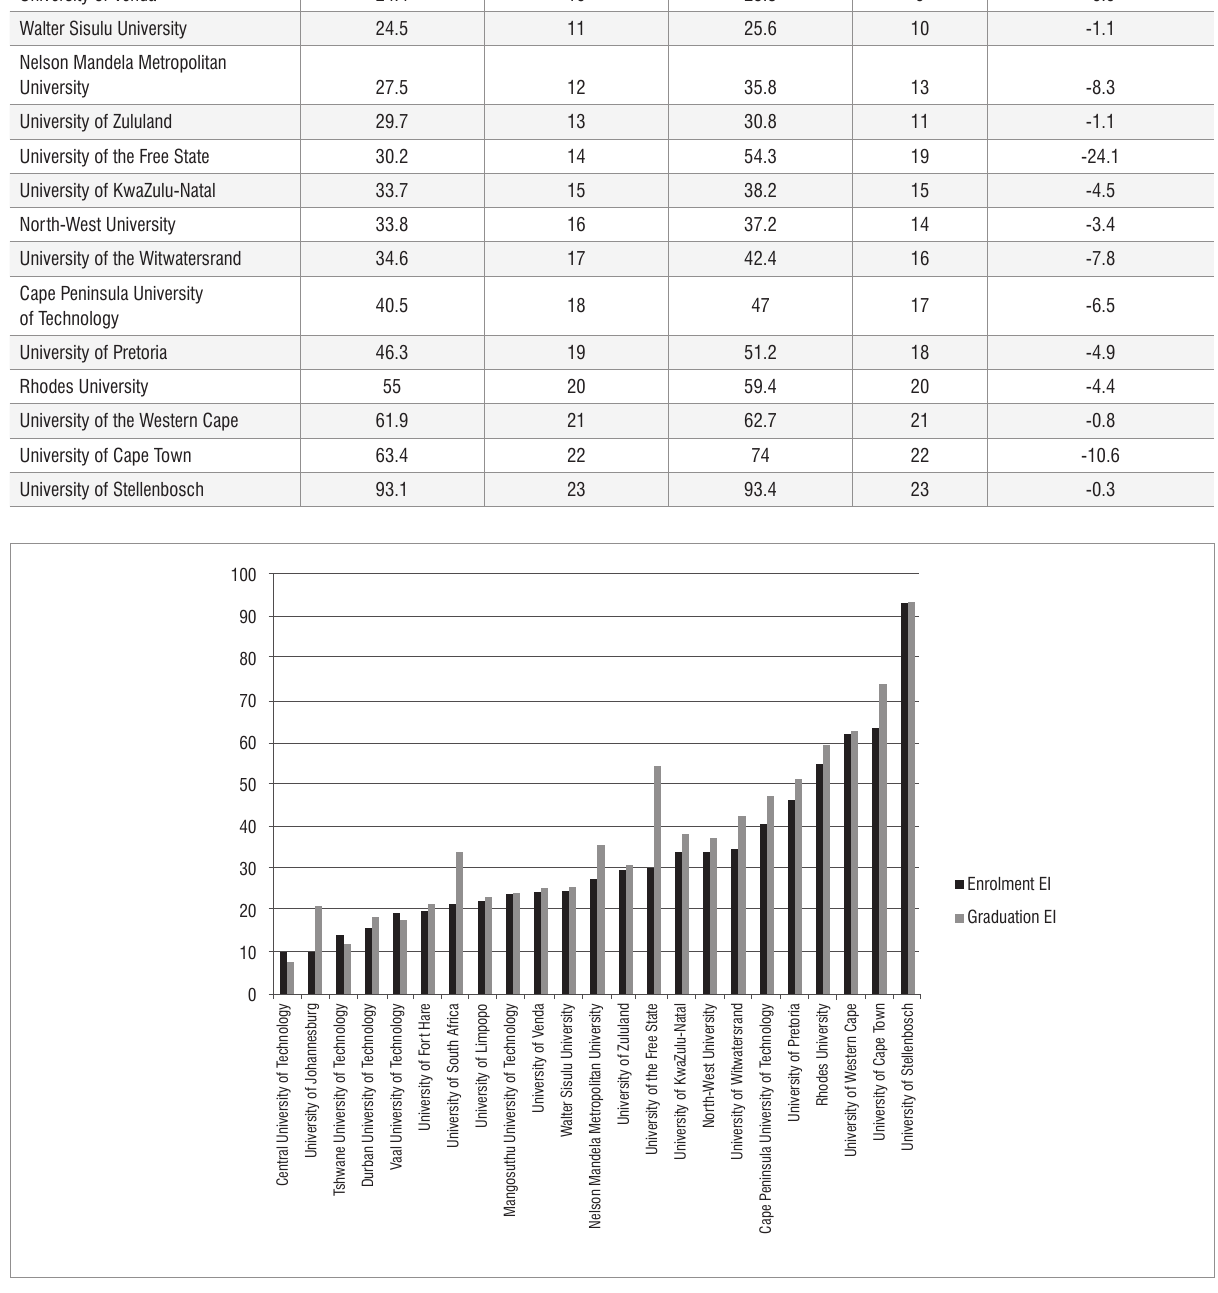
Figure 1: Graphical representation of South African student Equity Indices for South African